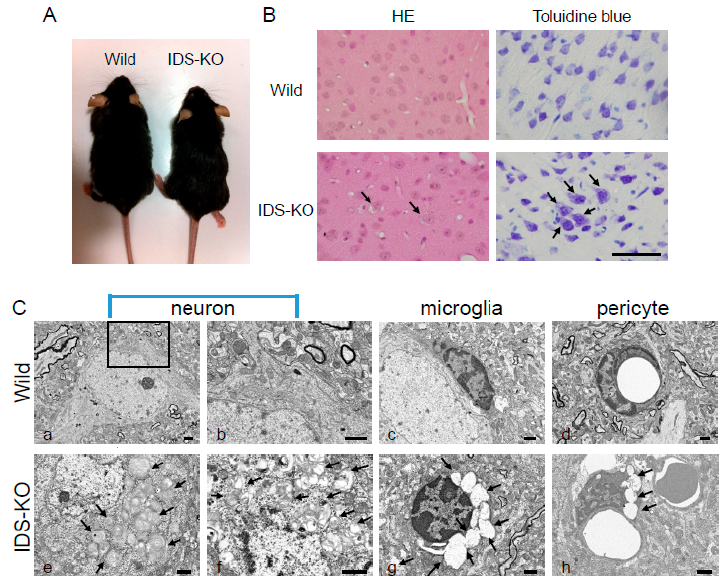
Figure 1. The appearance of wild-type and iduronic acid-2-sulfatase (IDS)-knockout (KO) mice. ( A ) The appearance of IDS-KO mice was not markedly changed. ( B ) Hematoxylin and eosin (HE) and toluidine blue (TB) staining of cerebral cortex from six-month-old mice. The neurons of the IDS-KO mice contained numerous vacuoles (arrows). Bar = 100 μ m. ( C ) Electron micrographs of the cerebral cortex of wild-type (a to d) and IDS-KO (e to h) mice: a, b, e, and f show neurons; c and g show microglia; d and h show pericytes. Panel b shows a higher magnification of the boxed area in a. Numerous spiral structures and layered structures (e) and autophagy-like vacuoles (f) were found in the cytoplasm of the neurons in IDS-KO mice, and numerous vacuoles were observed in the cytoplasm of the microglia (g) and pericytes (h). Arrows indicate vacuoles. Bar = 1 μ m.